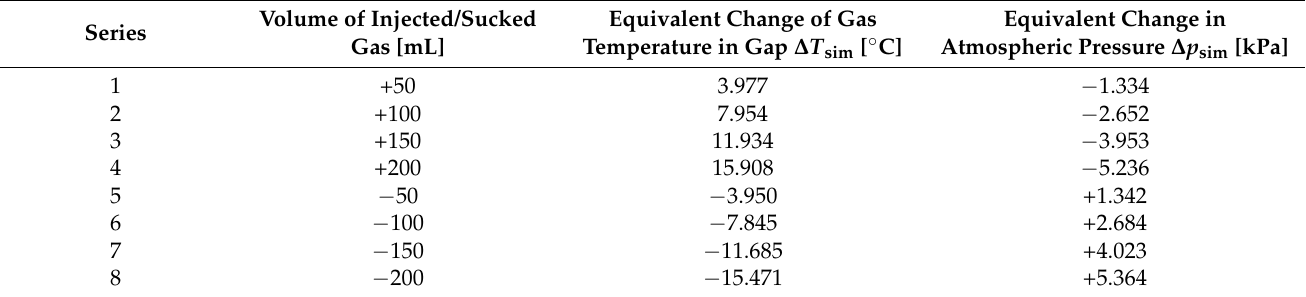
Table 1. Overview of